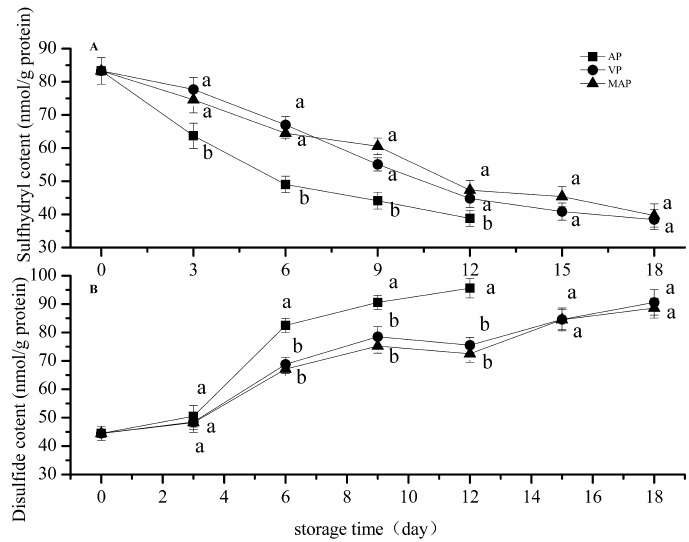
Figure 1. Changes in sulfhydryl (top) and disulfide (bottom) bond contents of grouper myofibrillar protein (AP: air packaging; VP: vacuum packaging; MAP: modified atmosphere packaging). Different lower-case letters in different groups from same day indicate a significant difference ( p < 0.05).